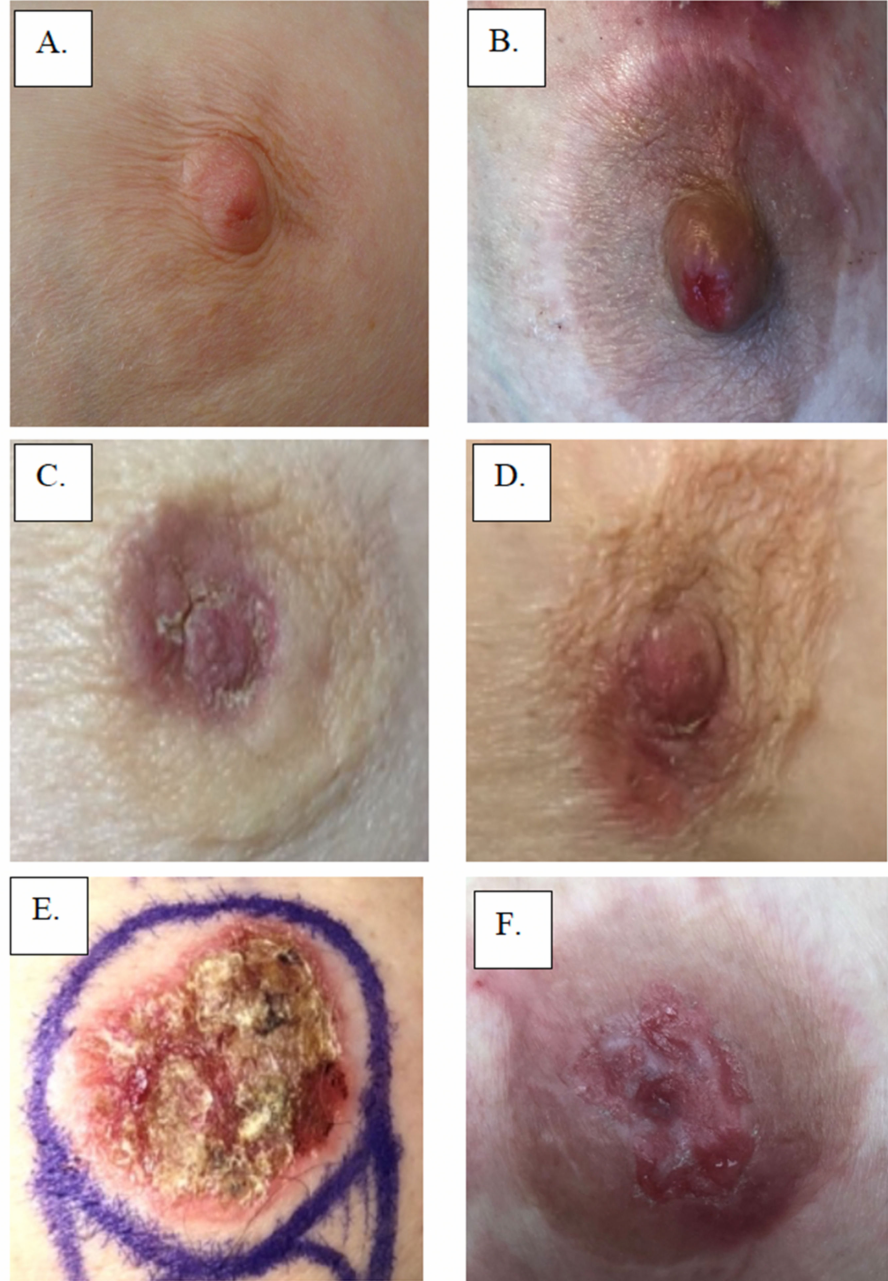
Figure 1. Examples of Paget’s Disease: ( A , B ) involving nipple only, ( C , D ) involving nipple and areola, and ( E , F ) showing effacement of the